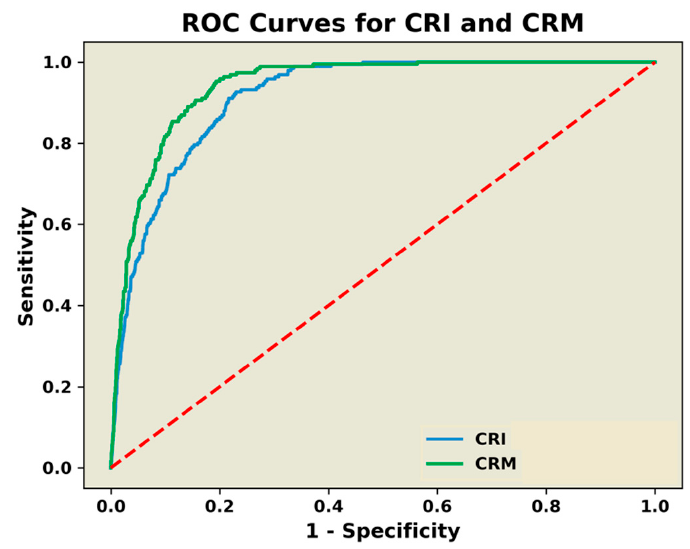
Figure 2. ROC AUC comparisons for prediction of the onset of decompensated shock between the compensatory reserve index (CRI—blue line) algorithm and the compensatory reserve metric (CRM—green line) algorithm. Diagonal broken red line represents a random guess threshold (i.e., no-discrimination line at 0.5).